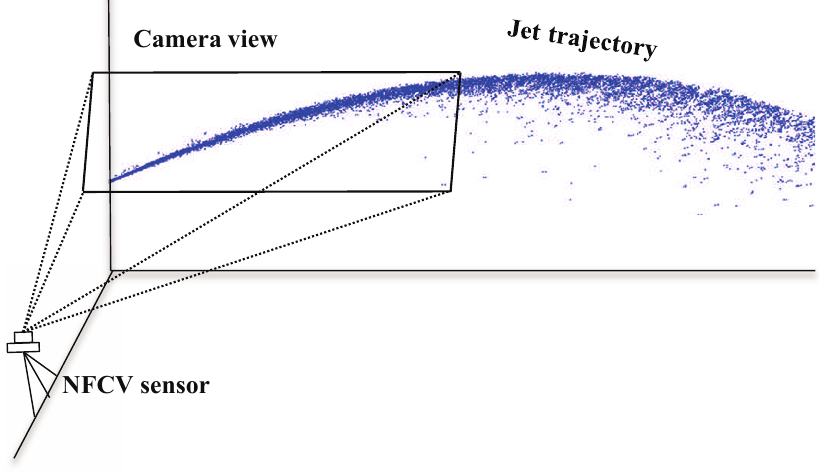
Figure 1. The structure of the near-field computer vision (NFCV) sensor